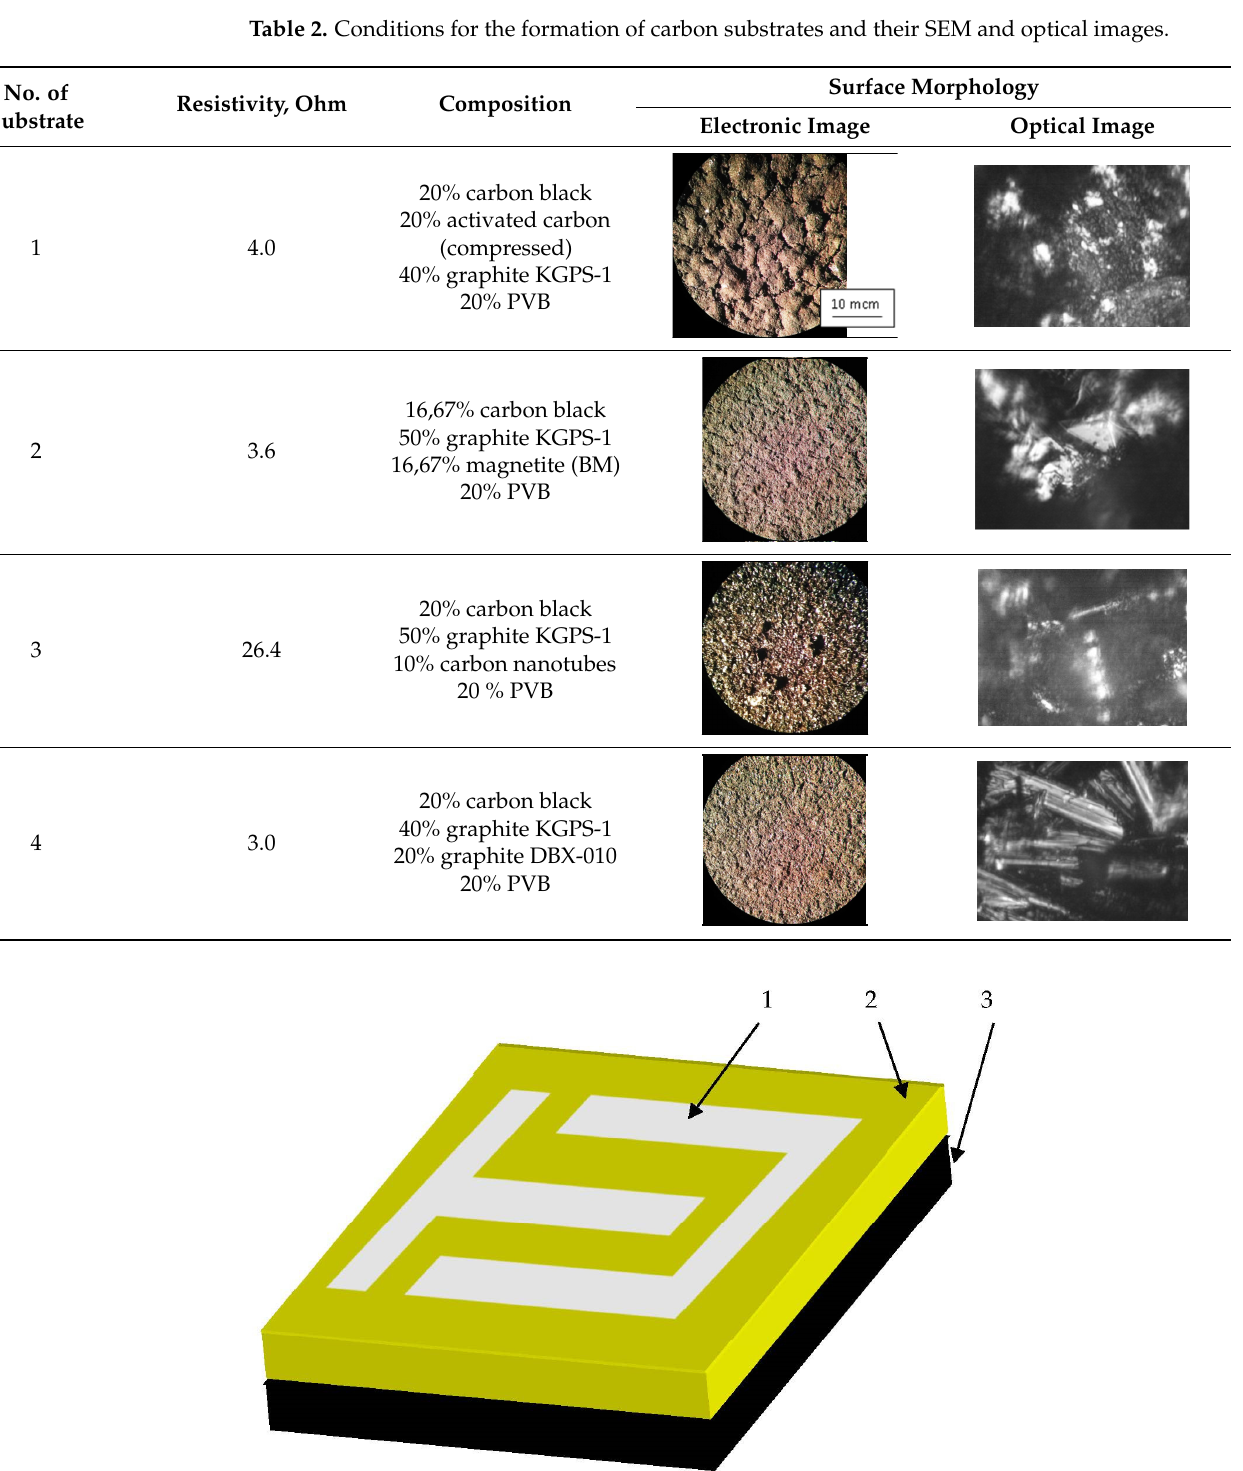
Table 2. Conditions for the formation of carbon substrates and their SEM and optical images.